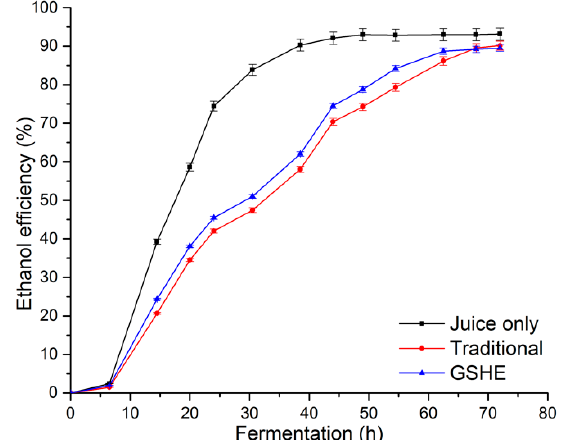
Figure 7. Ethanol conversion efficiency of juice only and juice plus sorghum grain flour with (Traditional) and without (GSHE) hydrolysis.